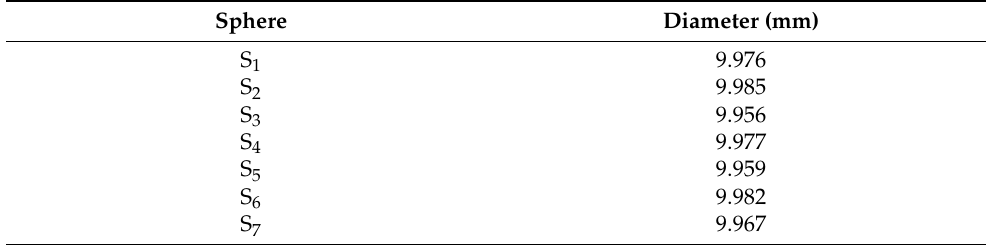
Table 1. Reference measurements for the diameter of each sphere based on the reference